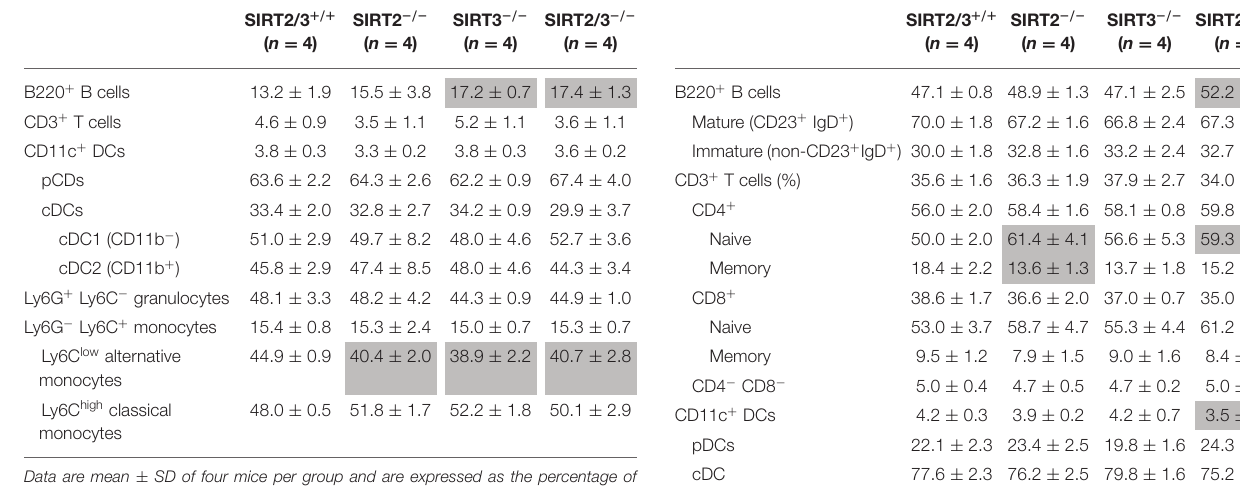
TABLE 3 | Splenic cell subsets.